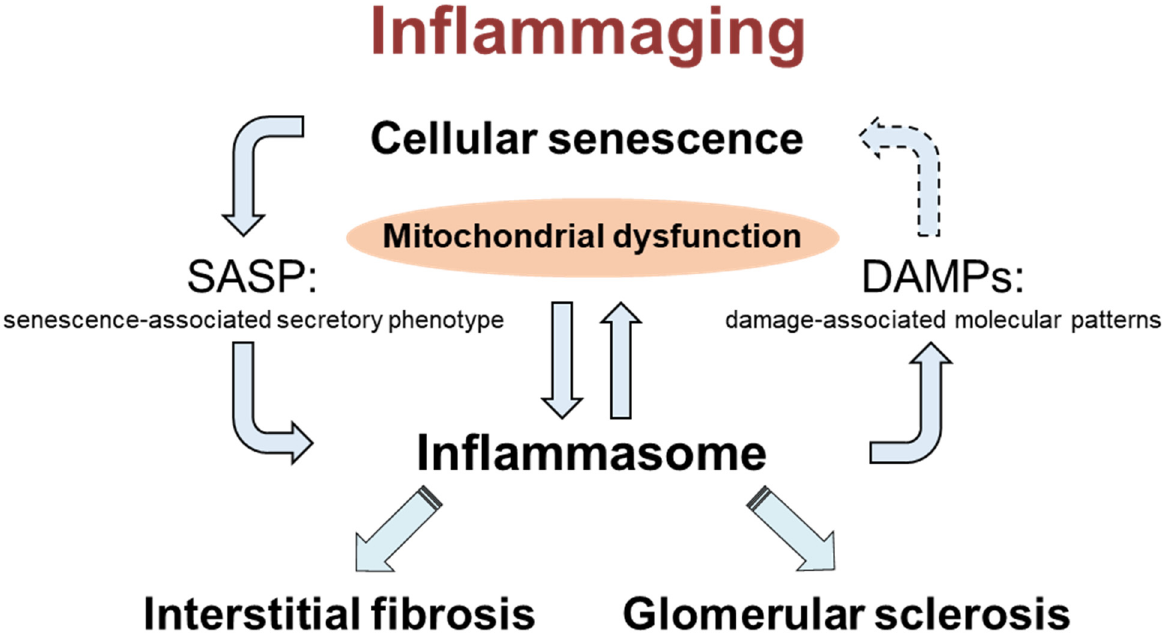
Figure 7. Scheme of the role of inflammasomes in ageing kidneys.